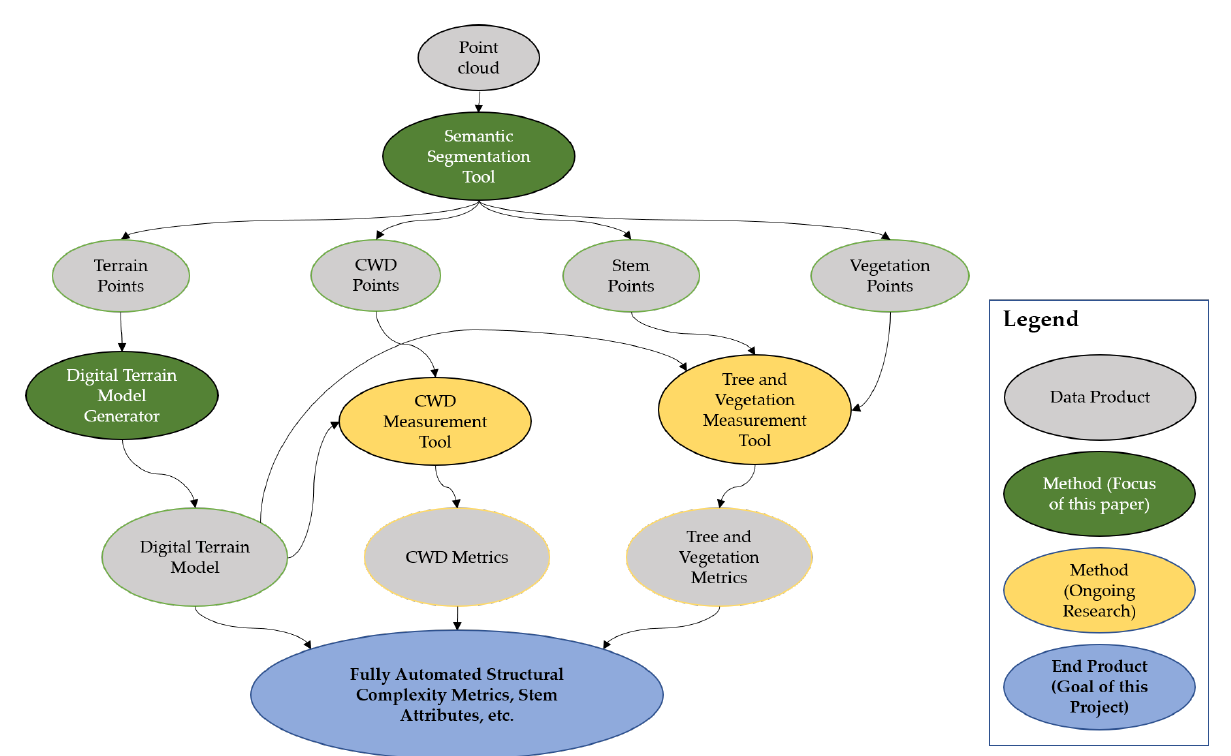
Figure 2. Schematic diagram describing how this research, which focuses on semantic segmentation and Digital Terrain Model generation, fits into our larger goal of creating a fully automated forest point cloud measurement tool.